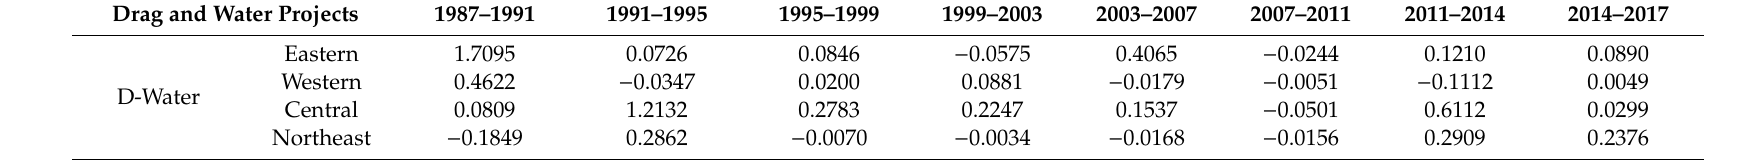
Table A3. Drag e ff ect of water resources and policies of water